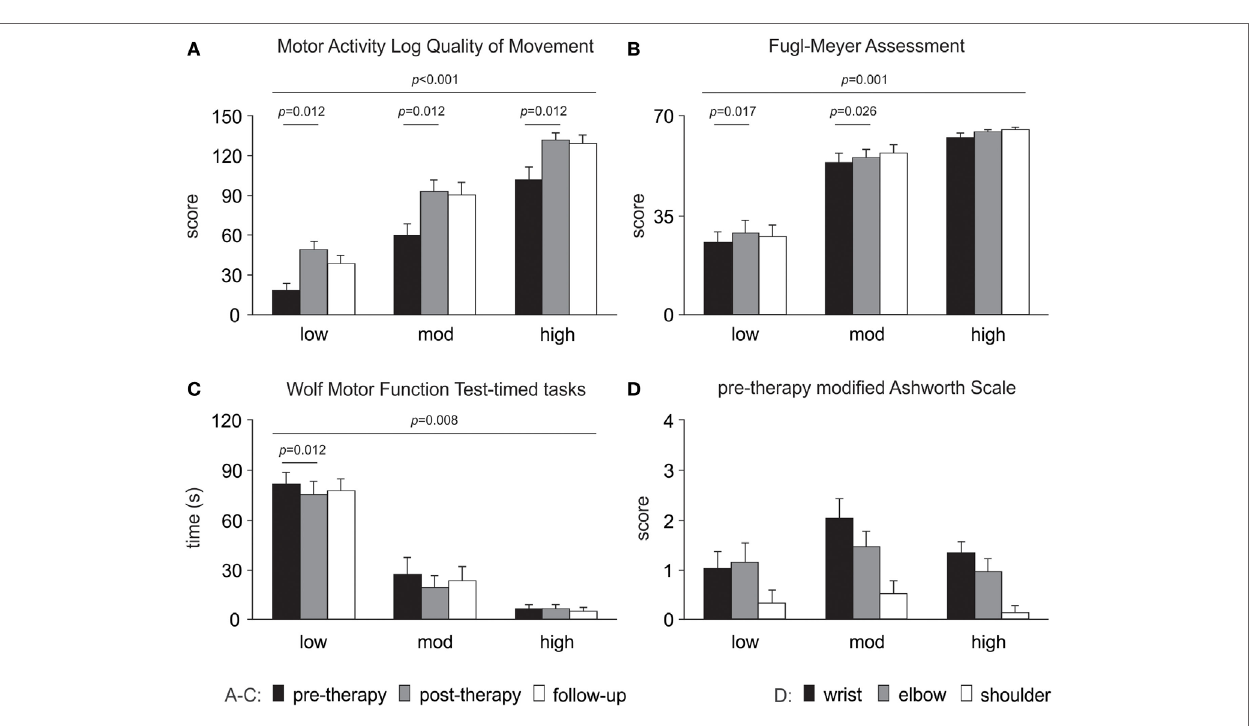
Figure 4 | Changes in clinical assessments over time. Significant changes are evident for (a) Motor Activity Log Quality of Movement scale, (b) upper limb motor Fugl-Meyer Assessment and (c) Wolf Motor Function Test-timed tasks (note a decrease in time reflects improved performance). (D) Modified Ashworth Scale pre-therapy (baseline) data are presented as there were no changes over time. All data are presented as mean ± SE.